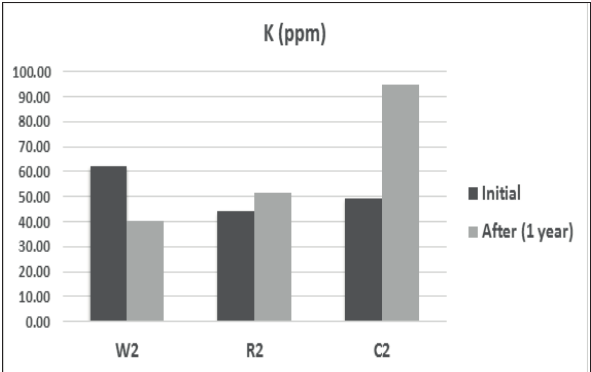
Figure 12. Soil available potassium content eight months after one year of cover crops establishment and trees planted in three farmers sites in Santo Tomas,